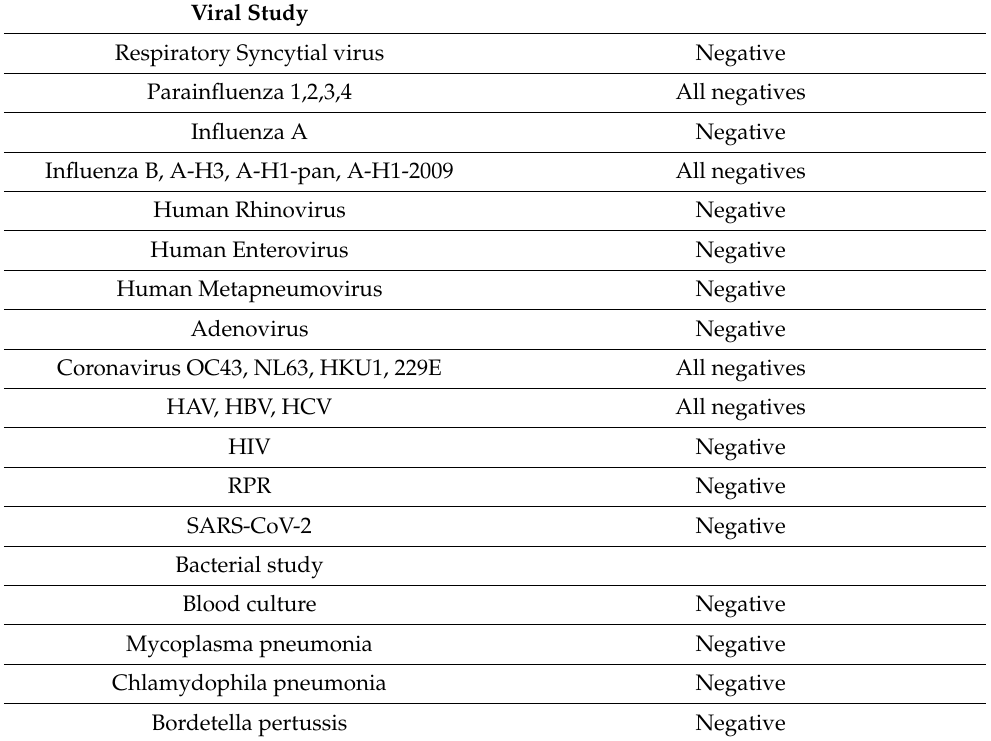
Table 1. Viral and bacterial studies of the